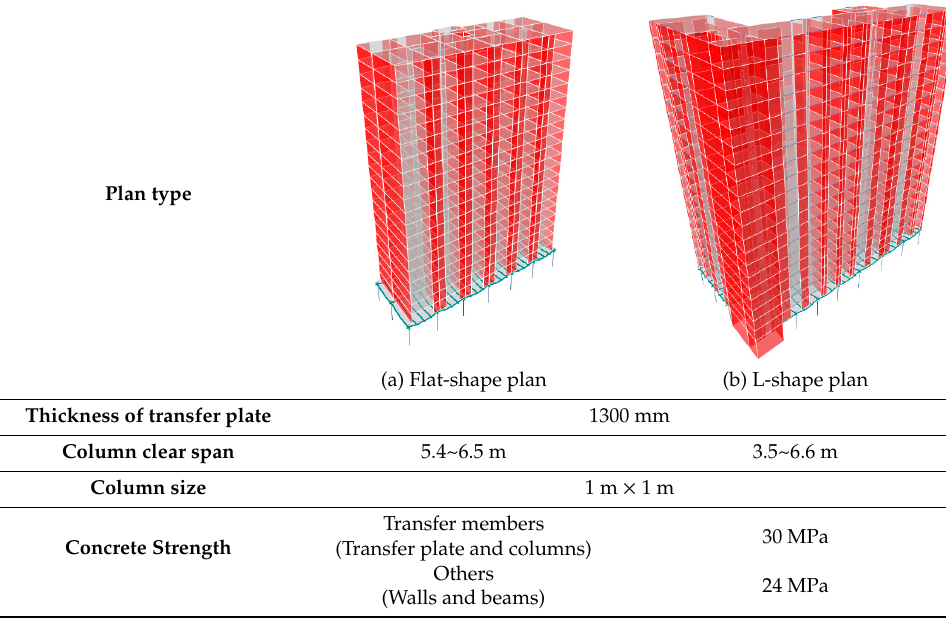
Table 1. Summary of the analytic model.